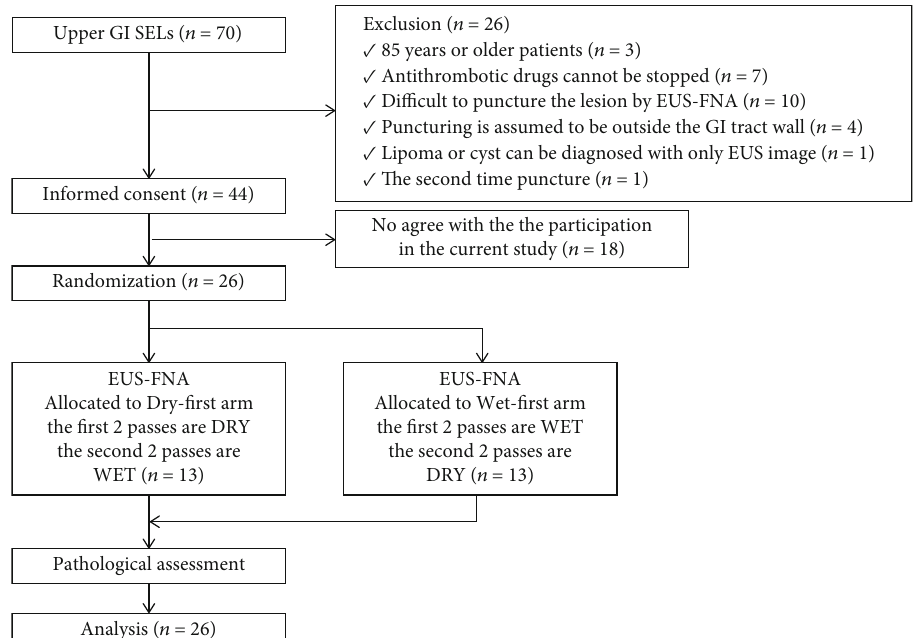
Figure 1: Flowchart illustrating the randomization and recruitment process of the study. GI: gastrointestinal; SEL: subepithelial lesion; EUS- FNA: endoscopic ultrasound-guided fi ne-needle aspiration; DRY: dry technique; WET: wet